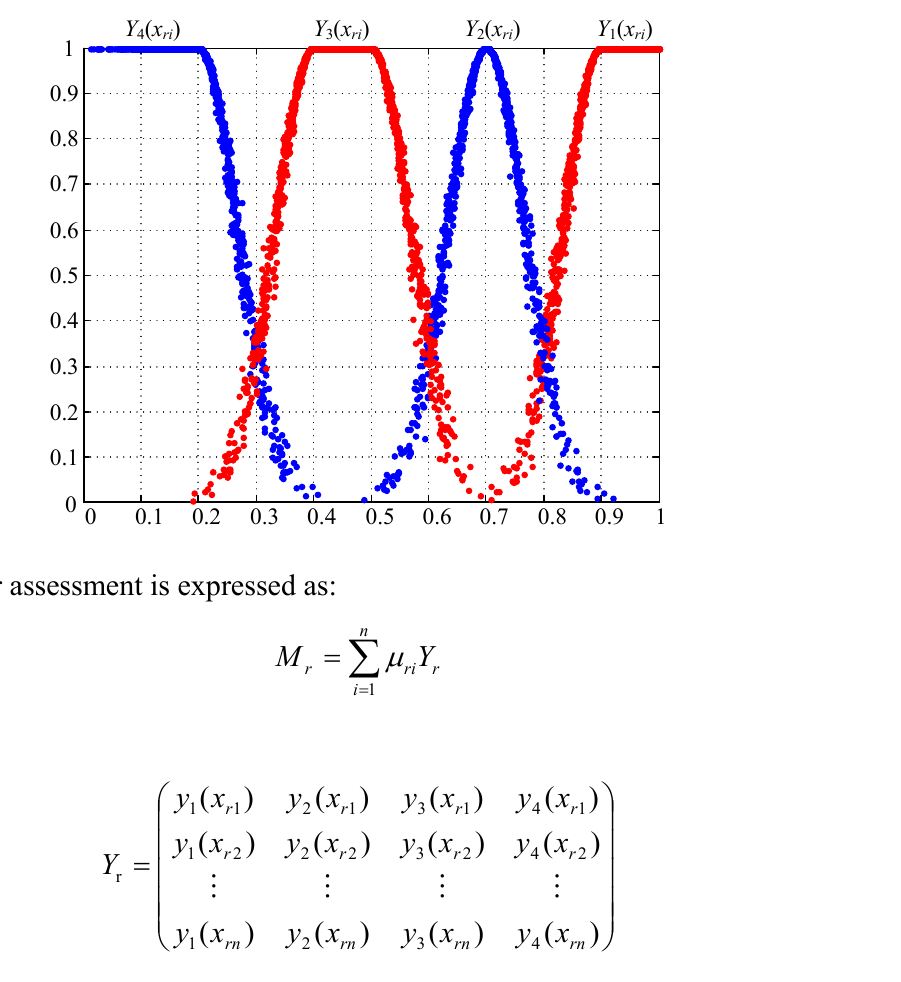
Figure 4. Sketch of TDCM membership degree